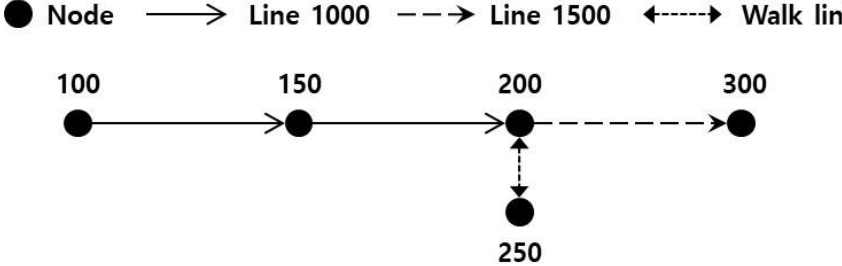
Figure 1. An example of a simple network.